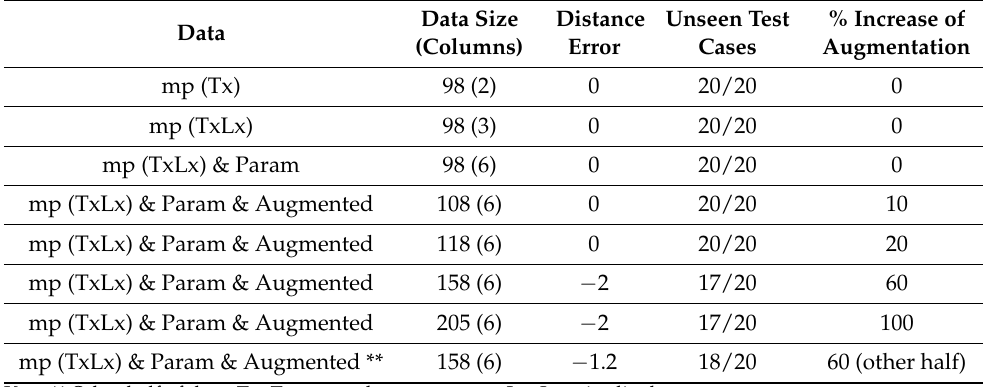
Table 3. CART results for normal data and different levels of dimensionality and